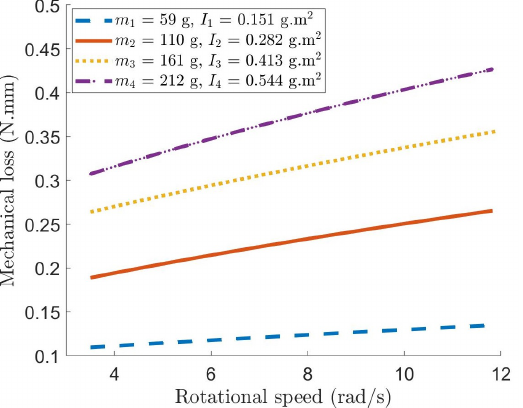
Figure 7. Measured mechanical losses of the single tower apparatus with different mounted